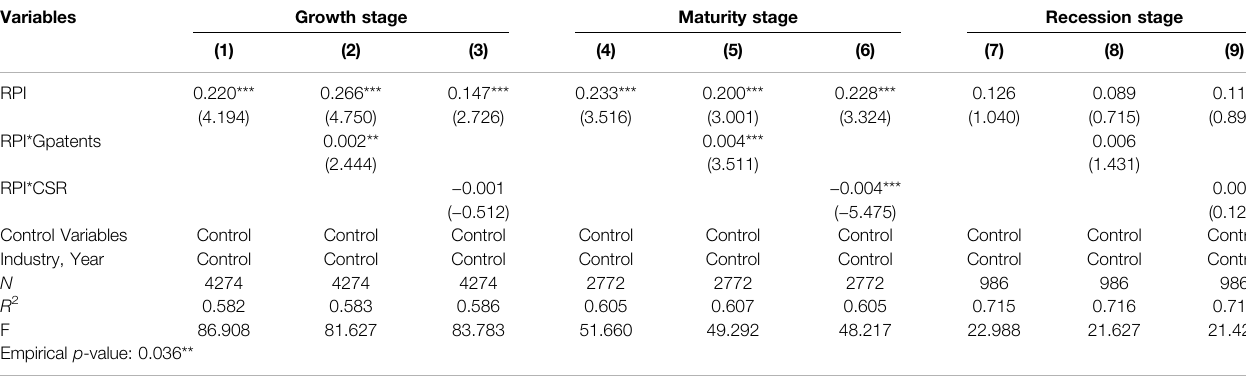
TABLE 12 | Sample regression results of different life cycle stages.